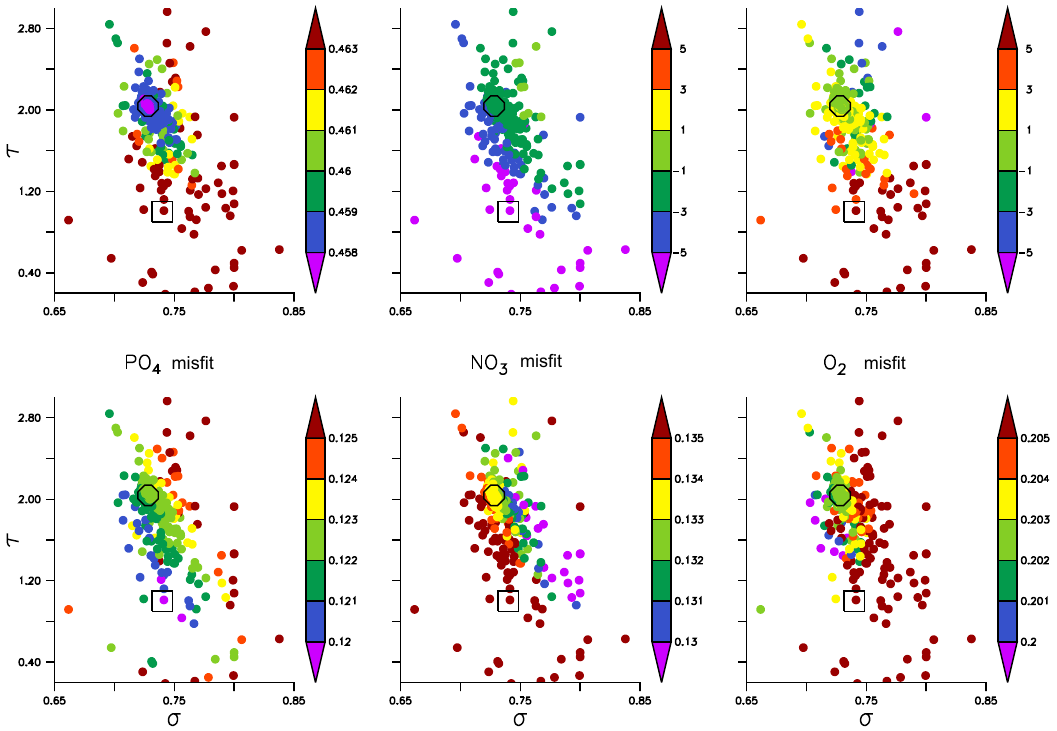
Figure 8. Model misfit and relative bias b j of RetroMOPS ◦ , plotted for parameter combinations of σ and DOP decay timescale τ , where τ = 1 /(λ + λ s ) . Relative bias is evaluated by b j = (m j /o j − 1 ) × 100, where m j denotes the global mean model concentration of tracer j , and o j the observed mean. Model misfit is shown as total misfit ( J of Eq. 11; upper left) and separated into its components, normalised by o j ( J(j ) of Eq. 11; lower panels). The analysis is restricted to all individuals i whose b differs less than 5% from optimal b ∗ , i.e. | b i /b ∗ − 1 | < 0 . 05. For better visibility some model solutions ( ≈ 10) that are outside the range 0 . 65 ≤ σ ≤ 0 . 85 and 0 . 2 ≤ τ ≤ 3 have been omitted from the plot. Open squares denote optimal estimates by Kwon and Primeau (2006, total phosphate constraint), open circles the optimal parameter from this